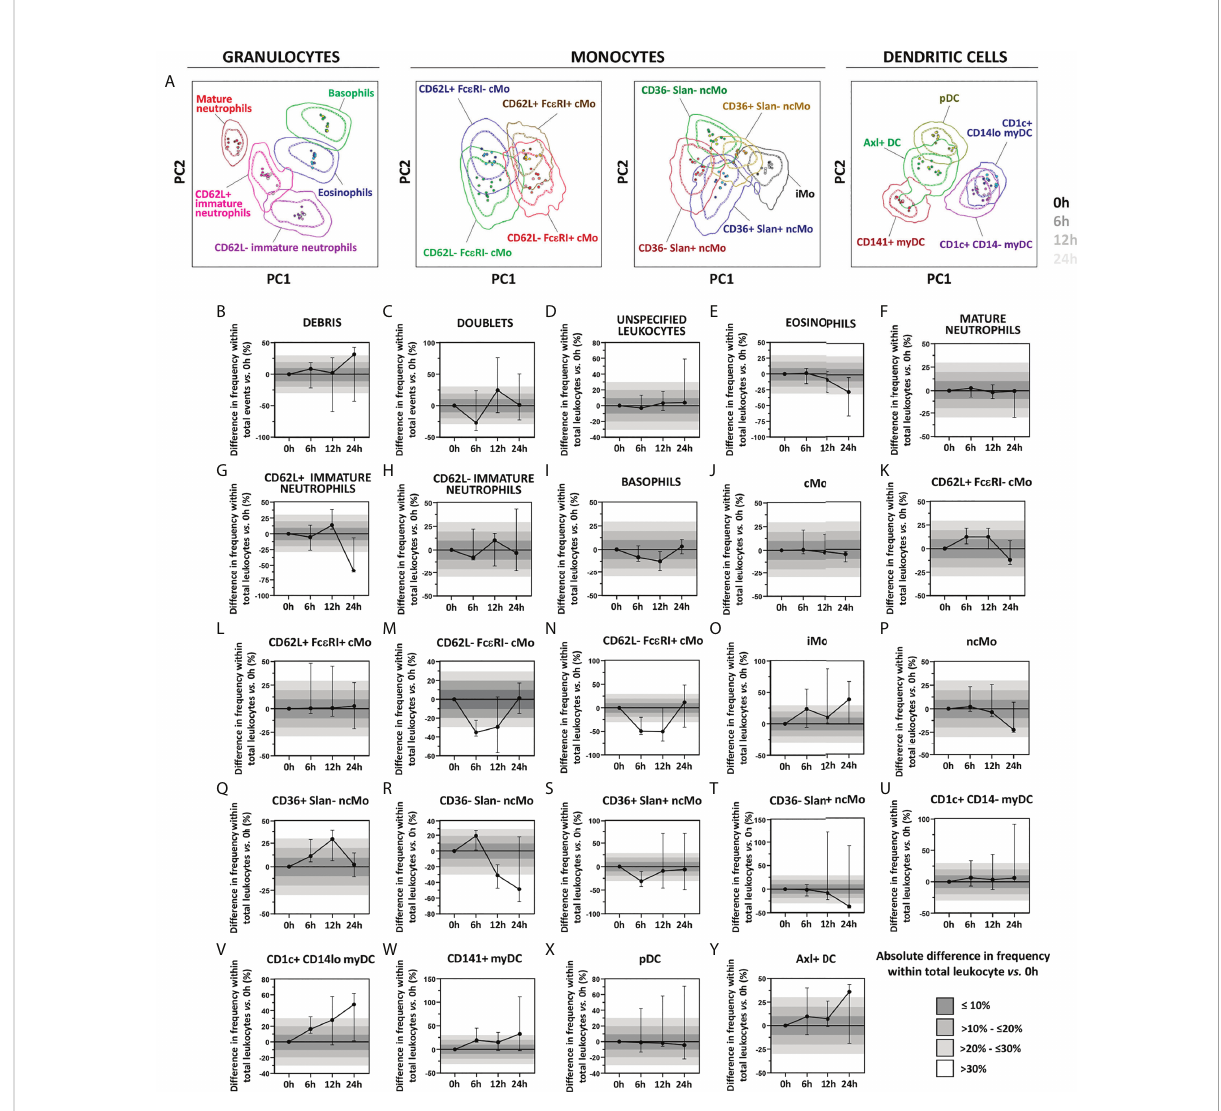
FIGURE 7 Impactofdelayedsampleprocessingontheoverallperformanceoftheinnatemyeloidpanelforpopulationidenti fi cationandquanti fi cationofinnatemyeloid cell(IMC)populationsinblood.Principalcomponentanalysis(PCA)plotsre fl ectingtheimpactofsamplestorage(6h,12hand24h,shownasdifferentshadesof thepopulationcolor)ontheimmunophenotypicpatternsvs.samplesprocessedimmediatelyuponcollection(0h)aredepictedinPanel A